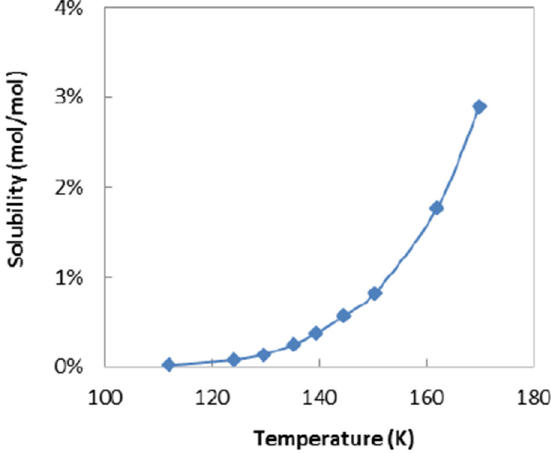
Figure 48. CO 2 solubility in liquid methane [193]. Reprinted (adapted) with permission